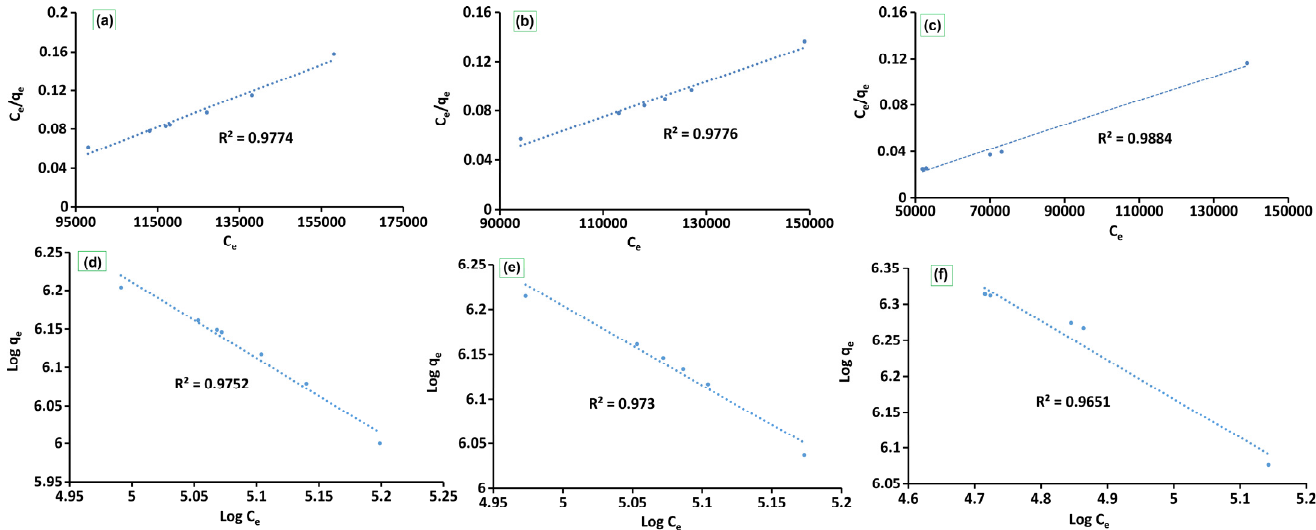
Figure 5. Comparison of the adsorption isotherm showing, the Langmuir isotherms models of ( a – c ), and the Freundlich isotherm models ( d – f ) of ESCaCO 3 NPs, RHSiO 2 NPs, and CS-SiO 2 /CaCO 3 NCs respectively.